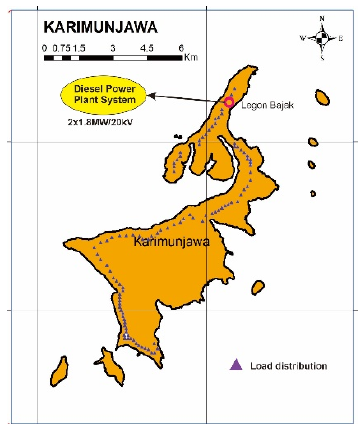
Figure 2 . Karimunjawa Island maps. Figure 2. Karimunjawa Island maps.